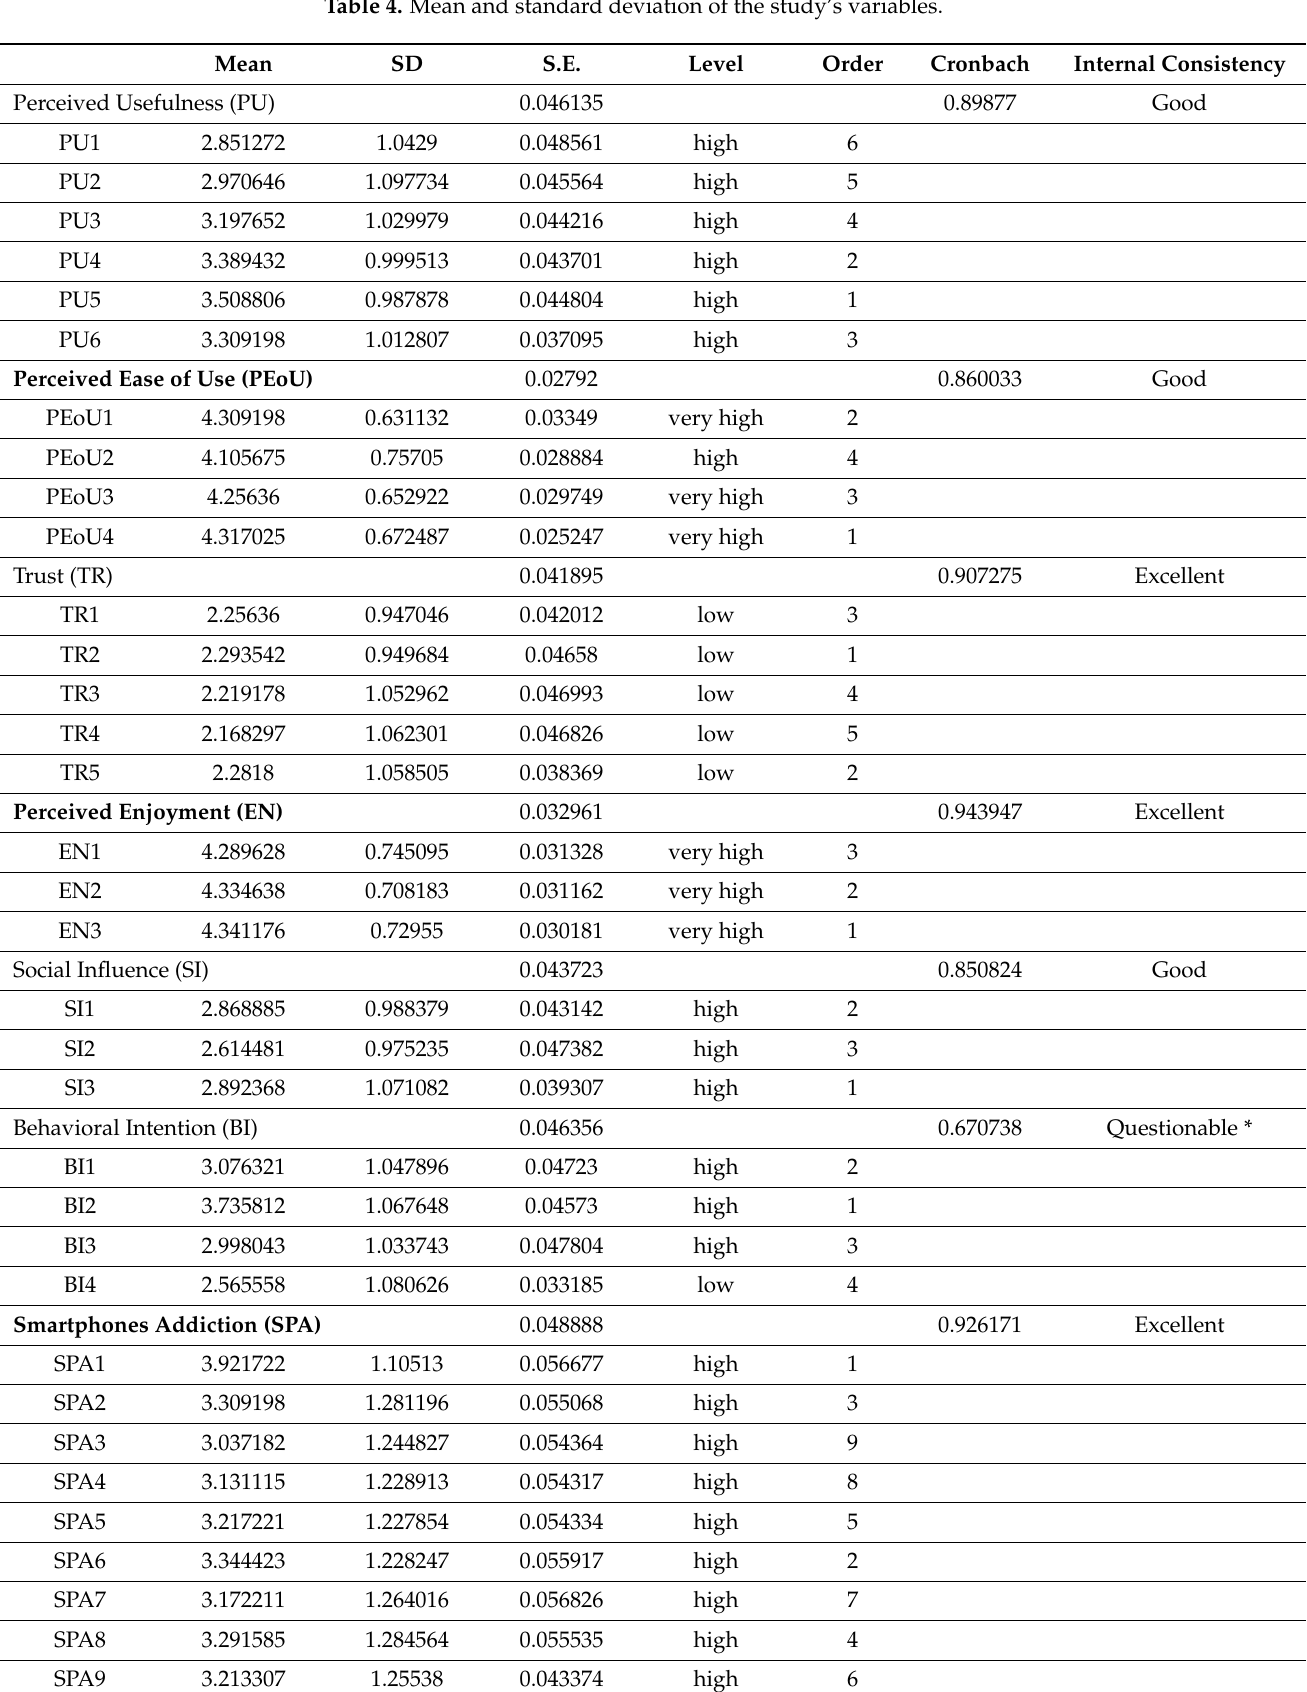
Table 4. Mean and standard deviation of the study’s